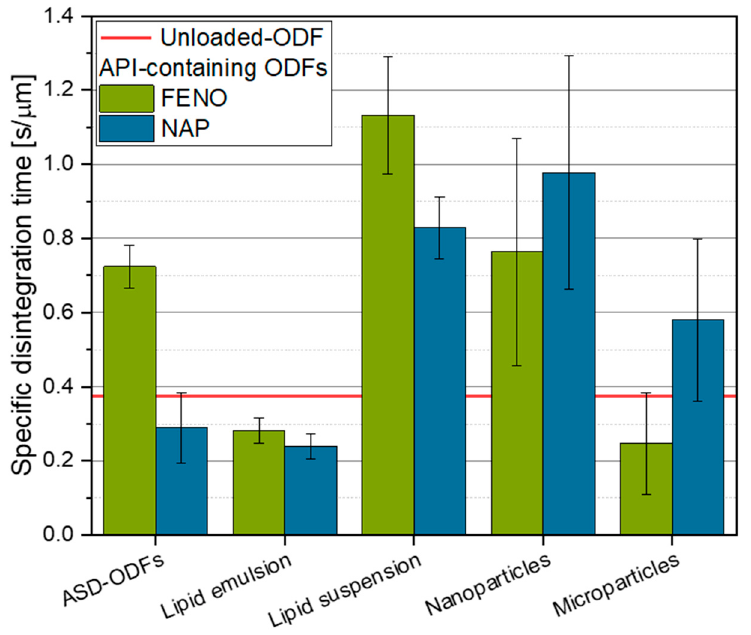
Figure 9. Influence of the film formulation strategy on the specific disintegration times of the FENO- and NAP-loaded ODFs, n = 4.